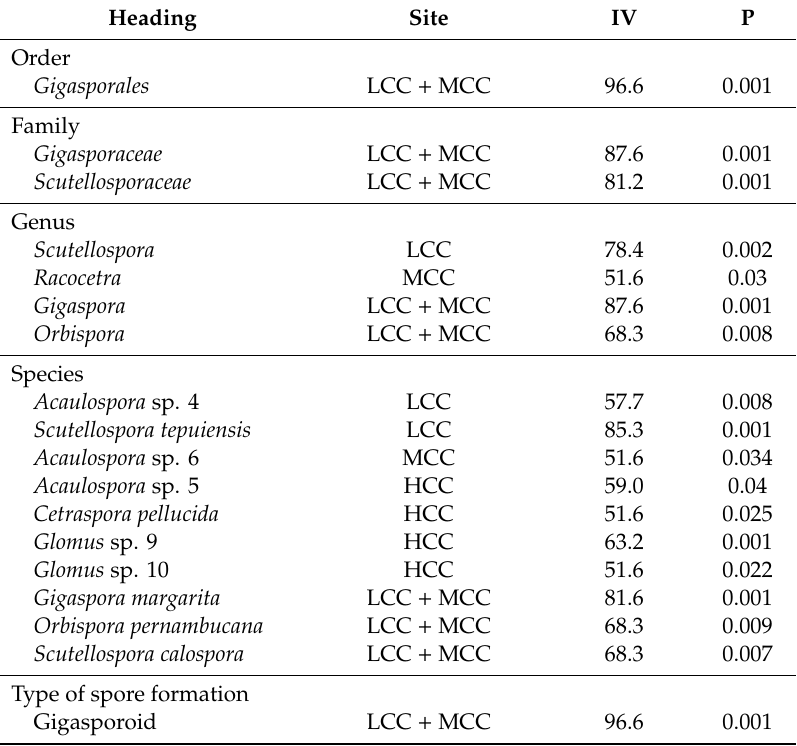
Table 3. Type of spore formation, species, genus, family, order of AMF indicators of some area according to the Monte Carlo test (IV ≥ 25%, p < 0.05). LCC: Low Clay Content, MCC: Medium Clay Content, HCC: High Clay Content.